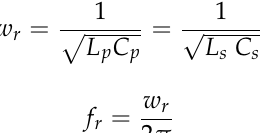
Figure 8. Equivalent circuit of wireless power transfer system.